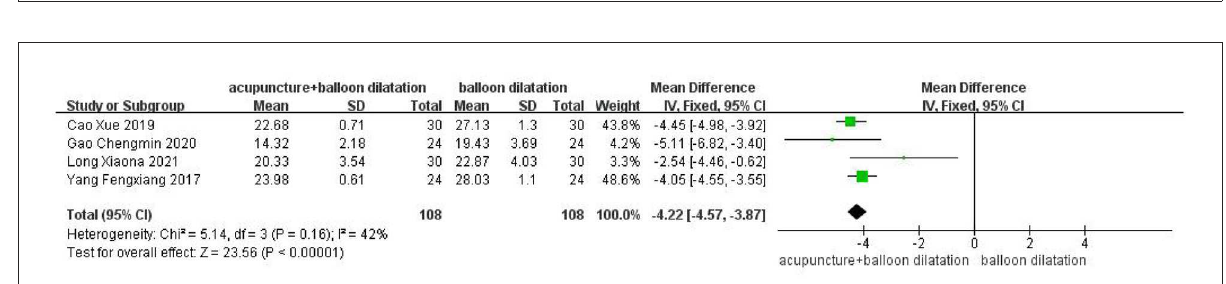
FIGURE4 Forest plot for the SSA score.